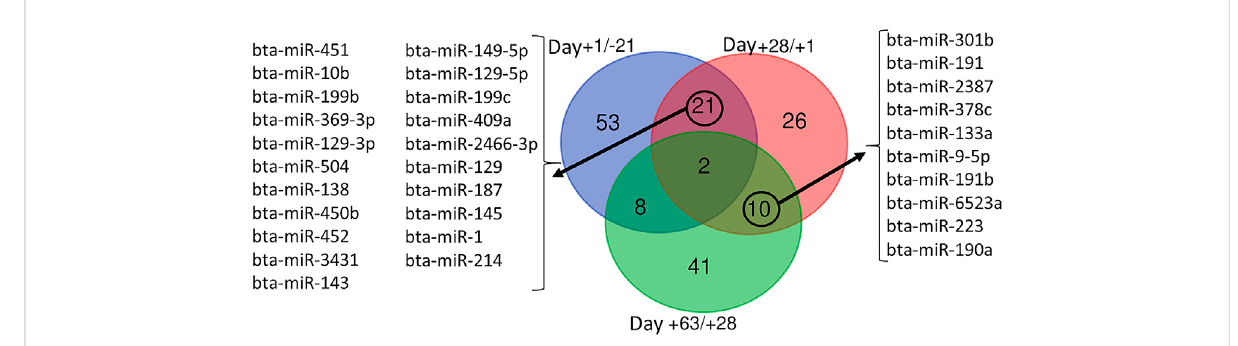
FIGURE 7 Venn diagram representing the overlap between differentially expressed miRNA during time series comparisons, including Day +1/-21 (blue), Day +28/+1 (red), and Day +63/+28